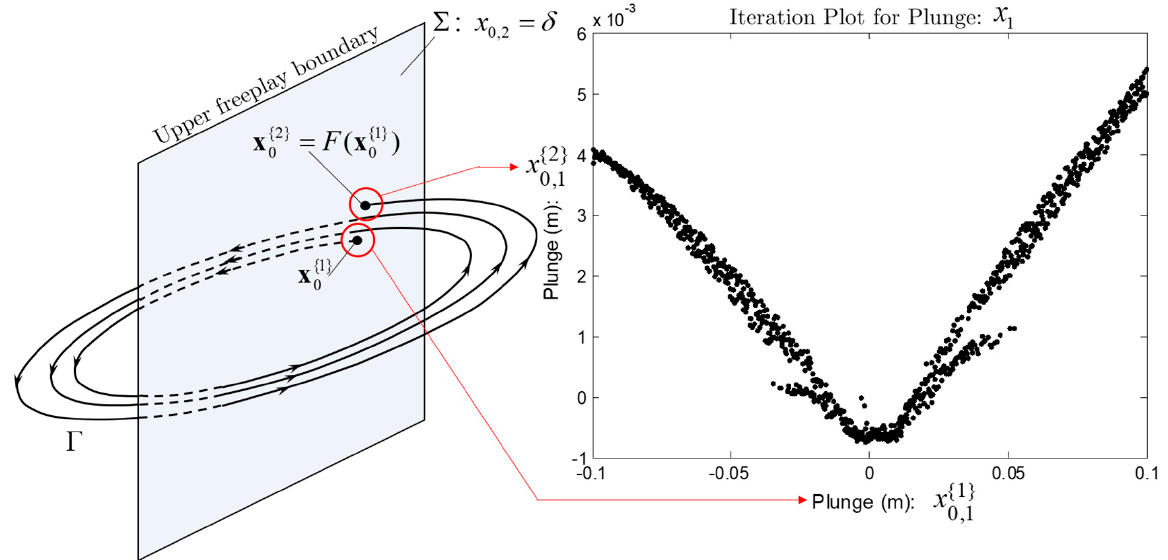
Figure 19. An interpretation of Figure 18, connecting the mapping F in state space and the iteration plot for pitch velocity. The airspeed is 20 m/s.